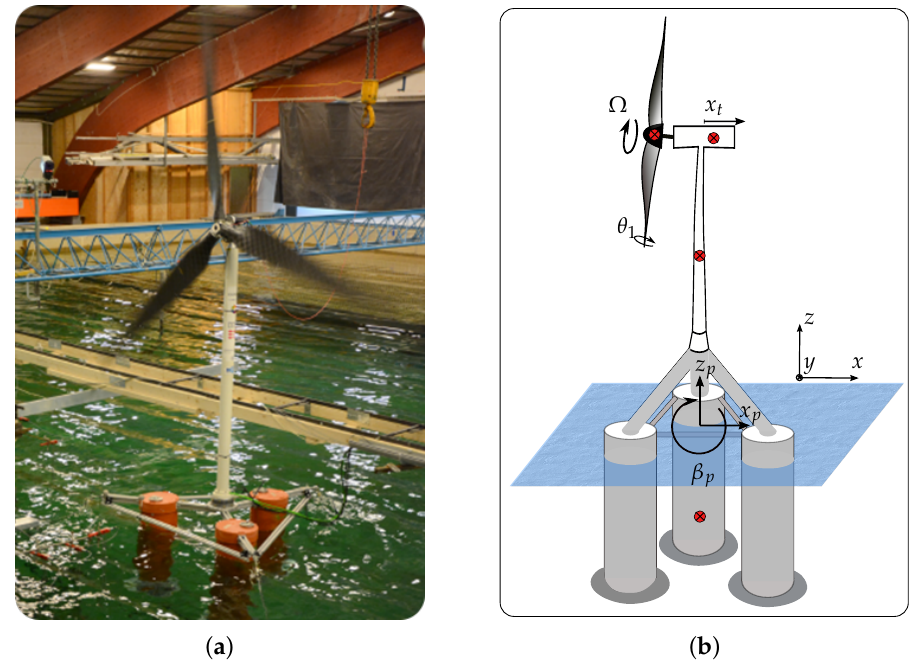
Figure 1. ( a ) TripleSpar scaled model (1:60), image reproduced from [39] with permission from Elsevier, 2018, and ( b ) mechanical sketch of low-order simulation model of Section 2.4 with generalized coordinates.